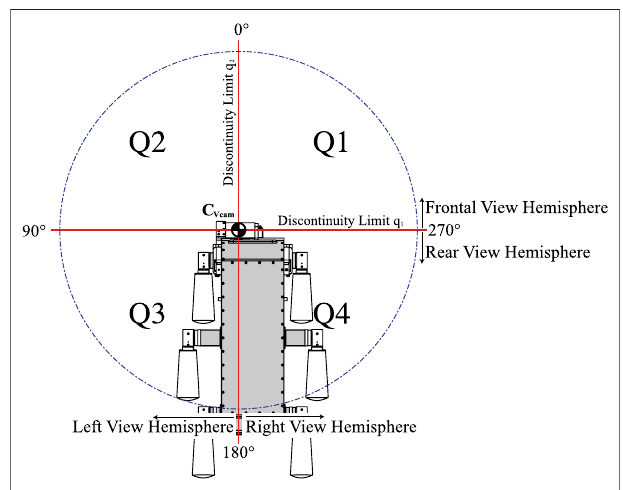
FIGURE 7 | Spherical vision range of the mirror system divided in